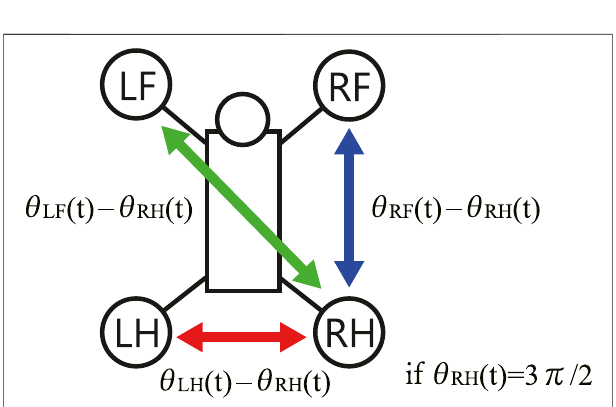
FIGURE 7 | The phase differences between the limbs on the Poincaré section.